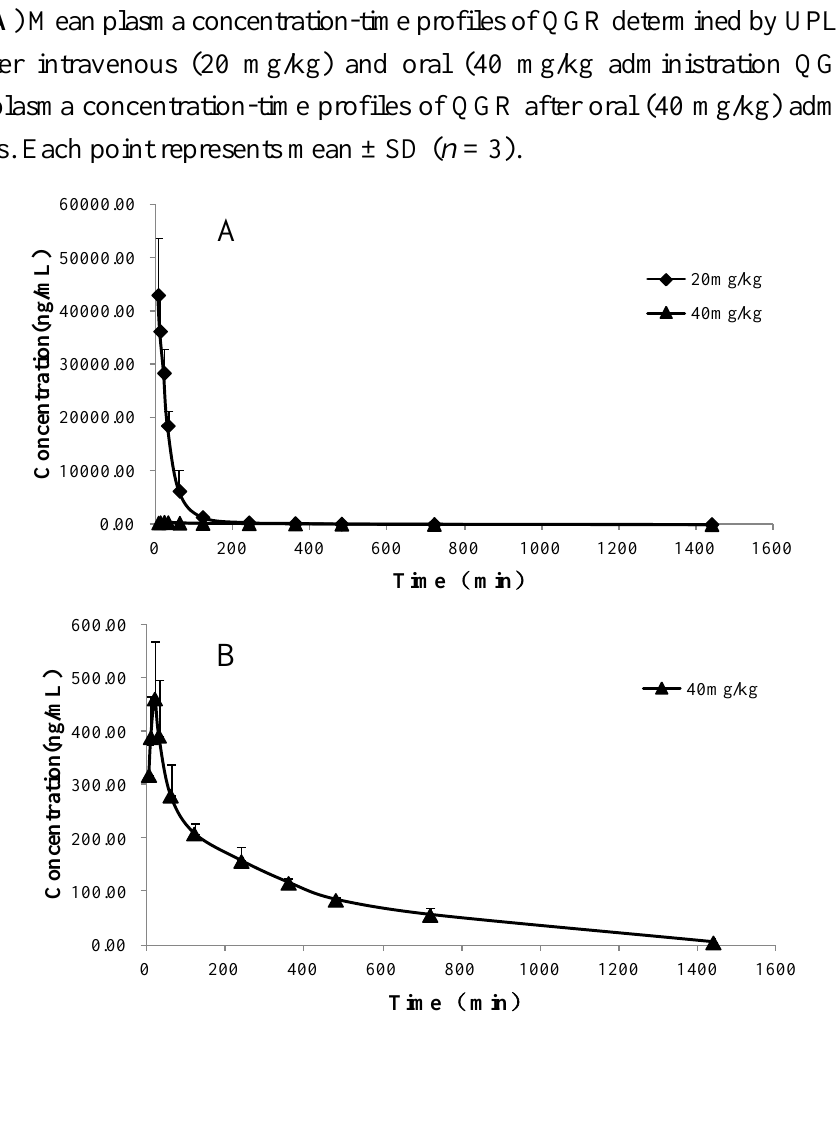
Figure 2. ( A ) Mean plasma concentration-time profiles of QGR determined by UPLC-MS/MS method after intravenous (20 mg/kg) and oral (40 mg/kg administration QGR to